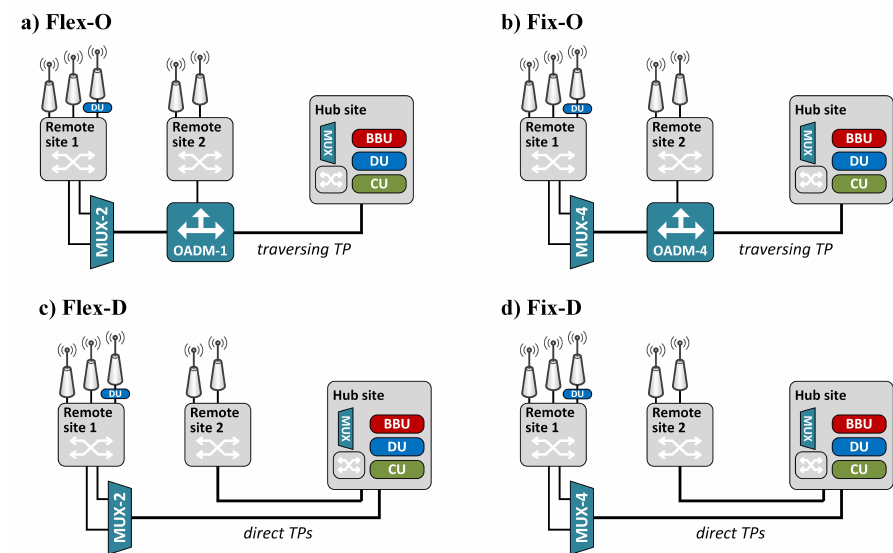
Figure 2. Considered packet-optical xHaul network deployment scenarios; a 4-channel WDM system is assumed in scenarios Fix-O and